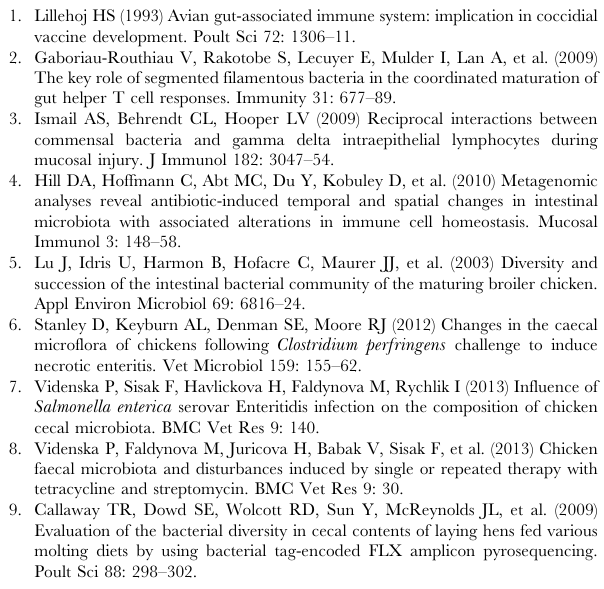
Figure S1 Composition of chicken fecal microbiota at the family level in 45 selected samples. Figure S2 Comparison of broiler and egg layer fecal microbiota. Table S1 List of raw Ct data for the quantification of antibiotic gene prevalence. Table S2 Dominant phyla found in the samples ana- lyzed in this study. Table S3 List of all OTUs identified in this